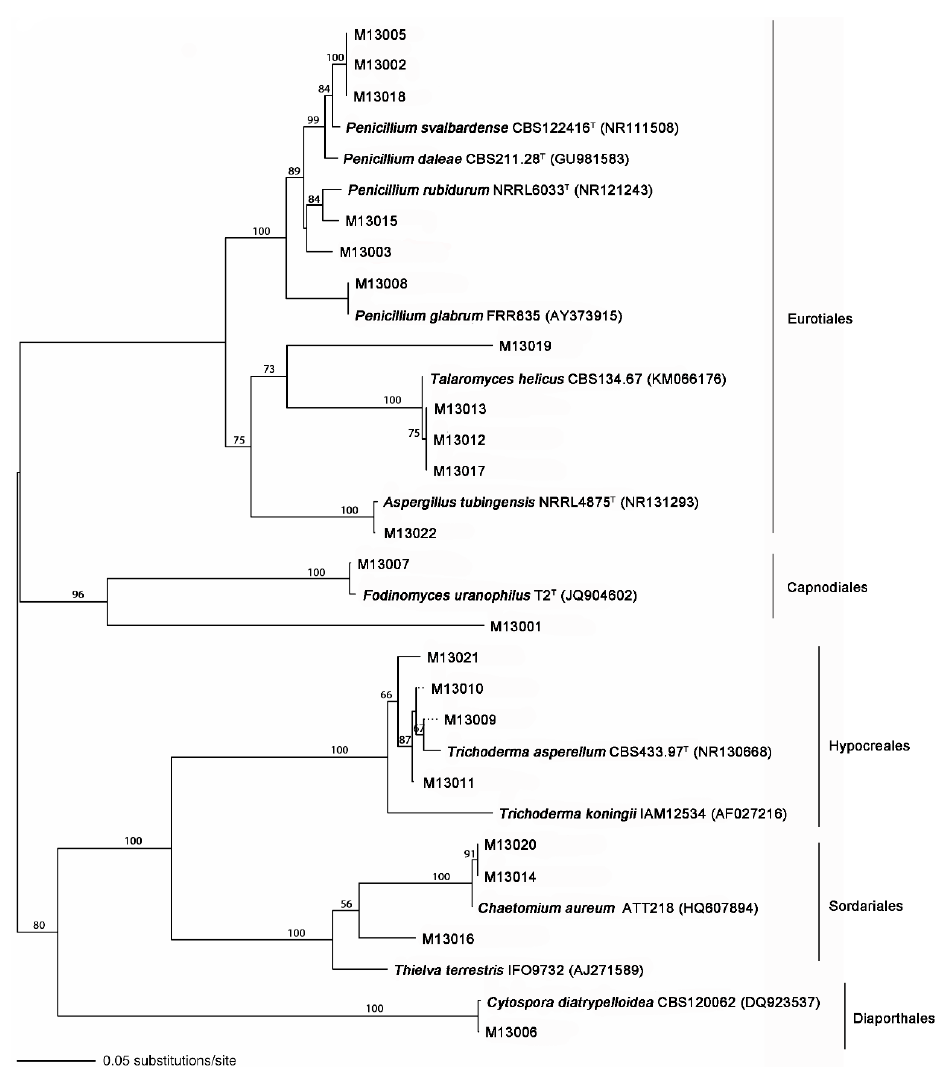
Figure 3. Neighbor-joining (NJ) tree showing the fungal isolates from M13. Numbers on branches correspond to Bootstrap index.